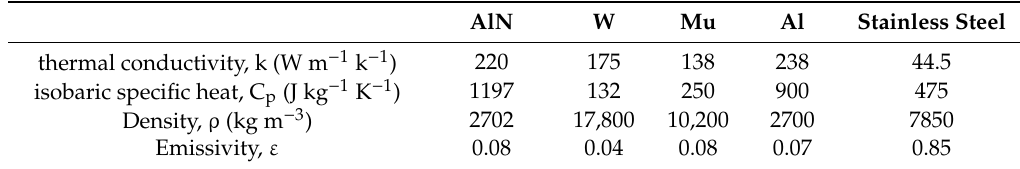
Table 1. Physical properties of the materials. AlN W Mu Al Stainless